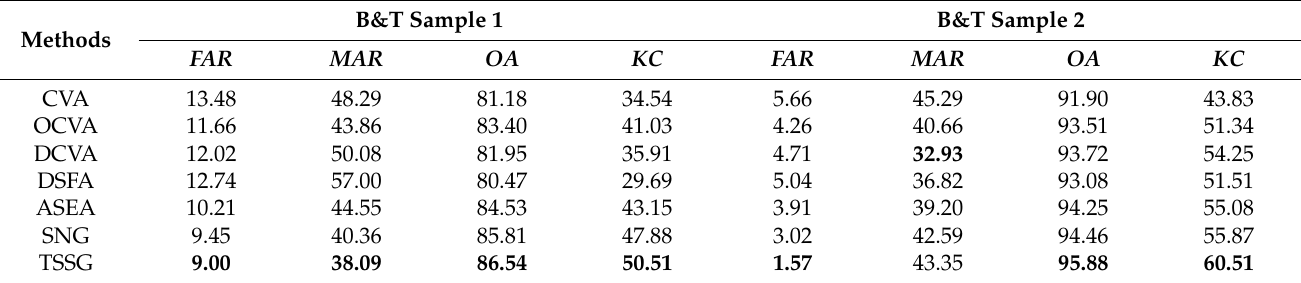
Table 3. Quantitative accuracy results for different methods on B&T data set (The best ones are shown by